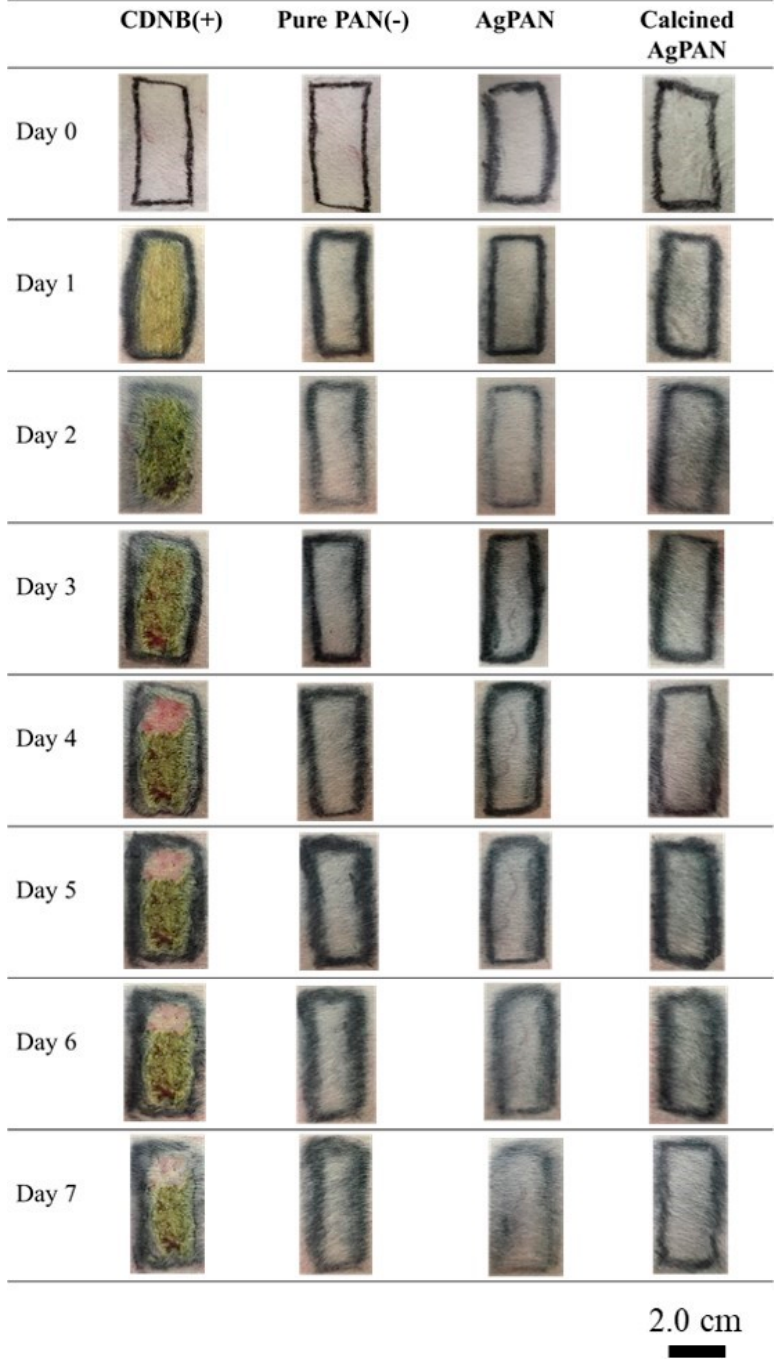
Figure 7. Testing for irritation of animal skin by various types of nonwoven mats for 7 days.